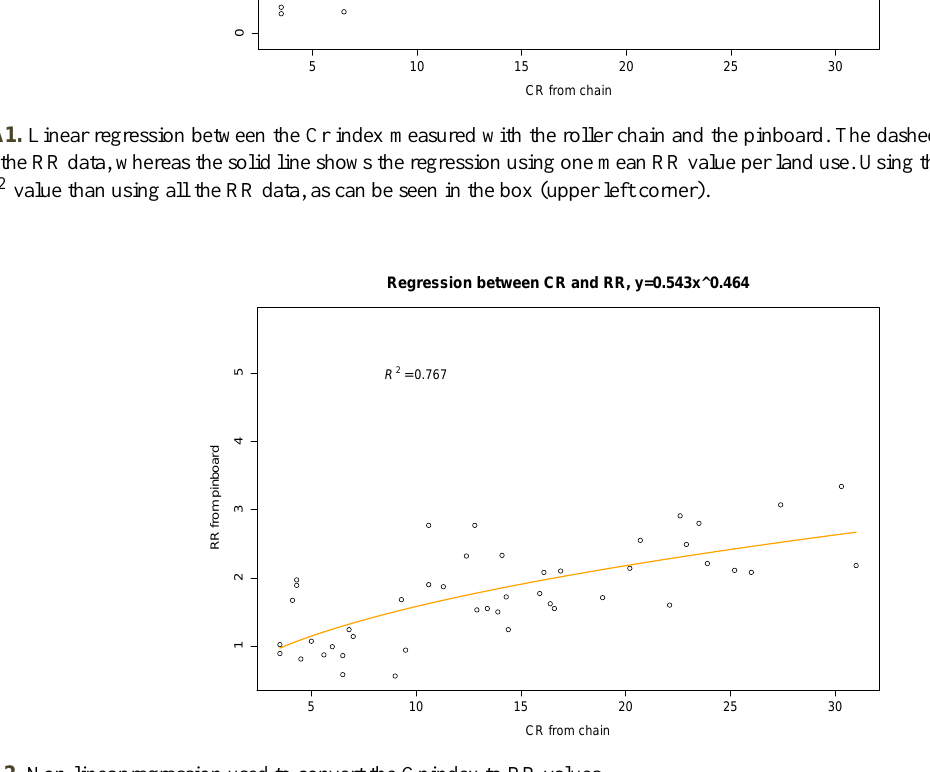
Figure A2. Non-linear regression used to convert the Cr index to RR